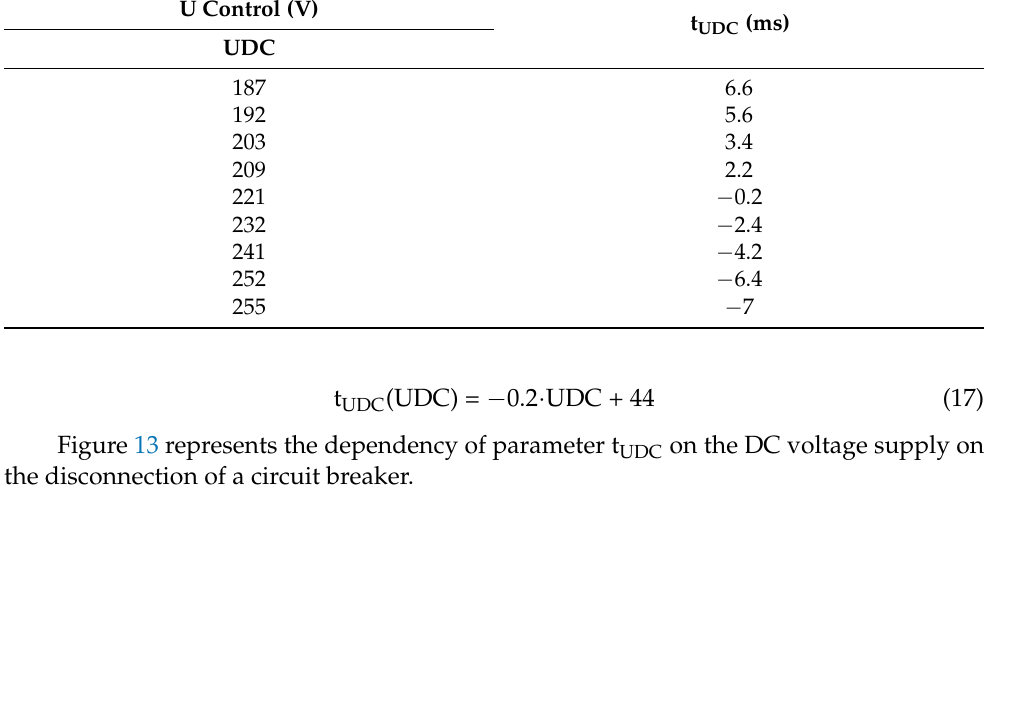
Table 3. Measured values of the dependency of time coefficient on DC voltage control.